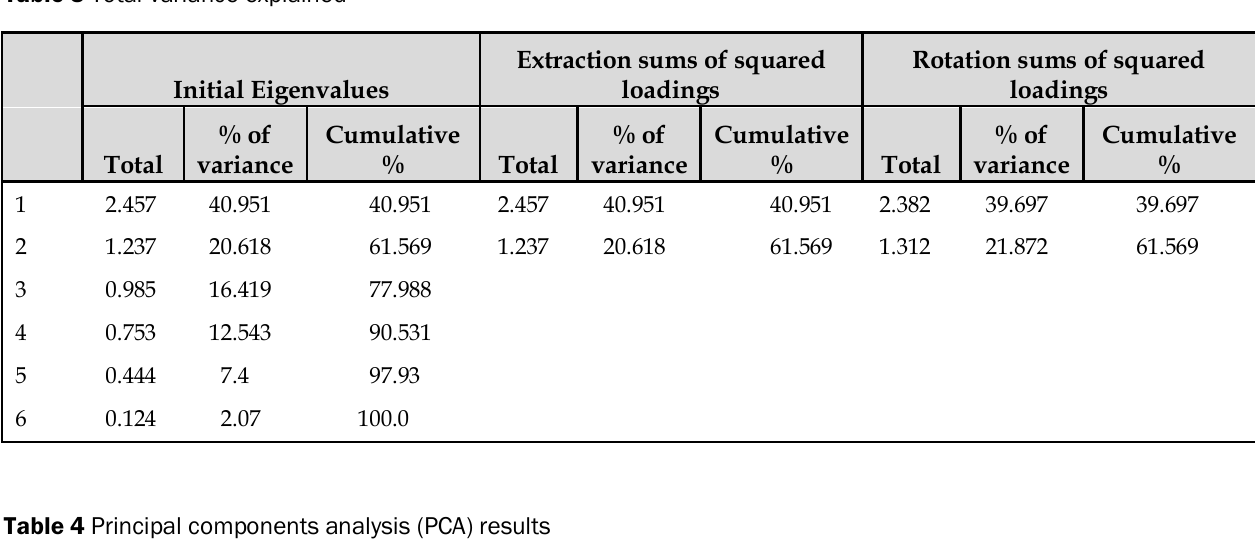
Table 3 Total variance explained